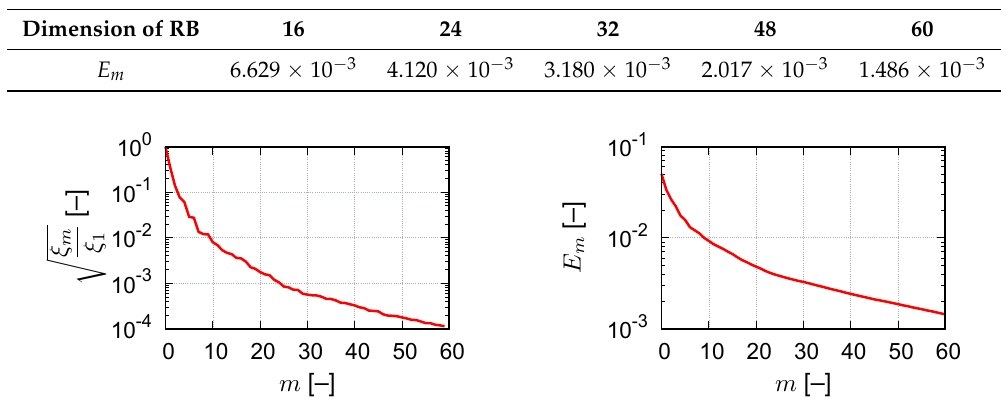
Table 1. Dimension of the RB vs. projection error for the snapshots.